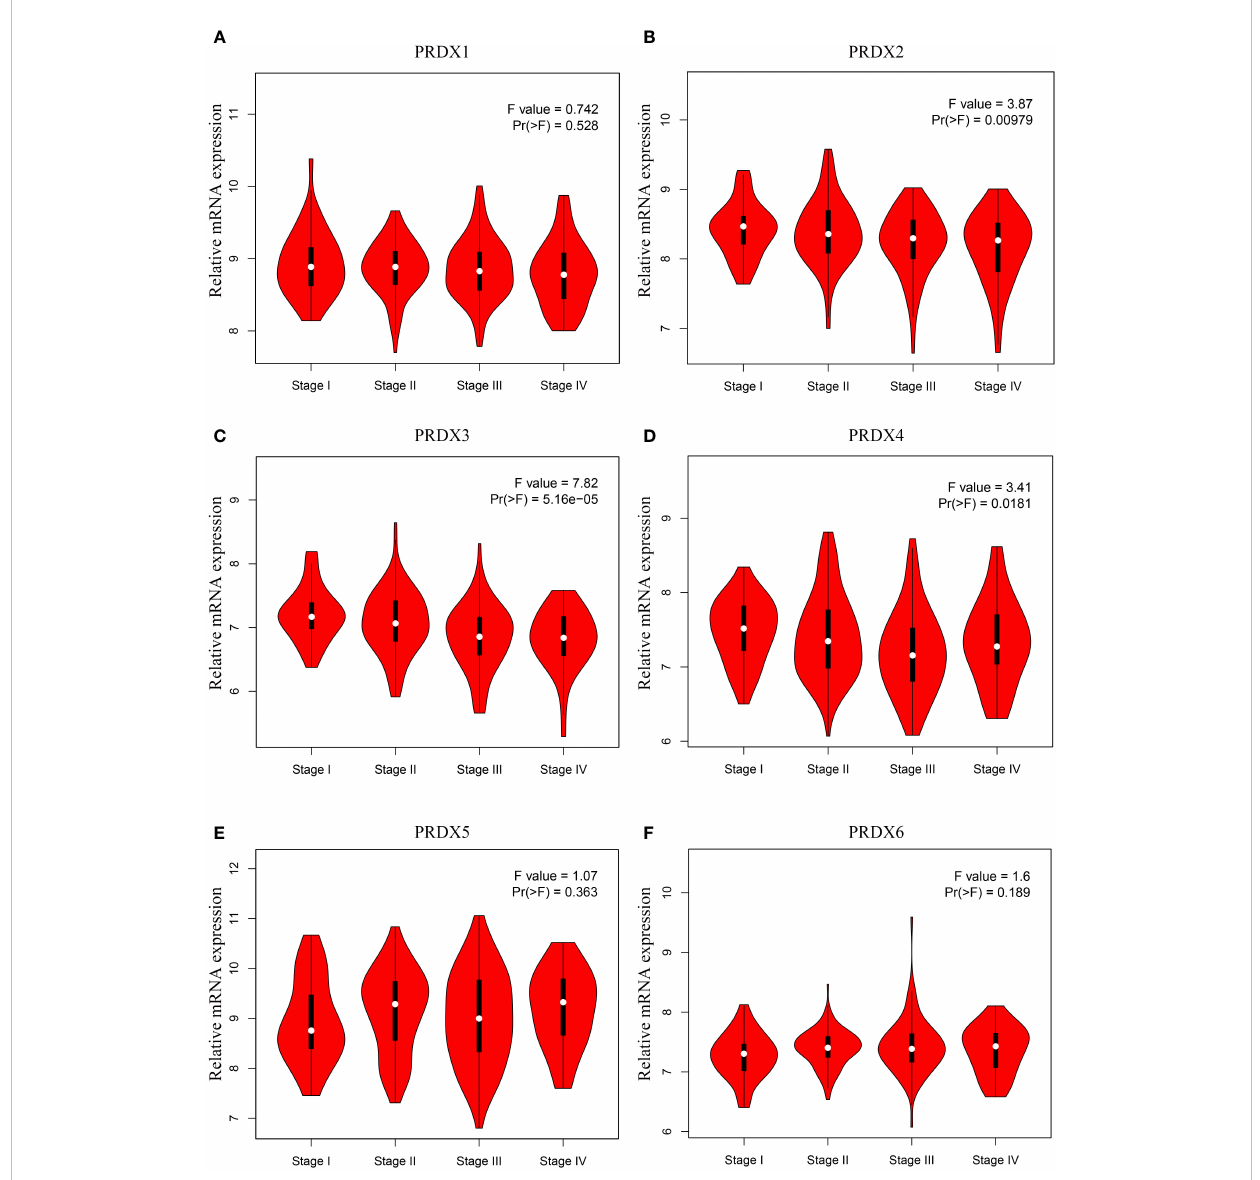
FIGURE 4 (A-F) Association between mRNA expression of PRDXs and tumor stage in COAD patients (GEPIA). The expression of PRDX2, PRDX3 and PRDX4 was signi fi cantly correlated with the pathological stage of COAD patients ( P < 0.05). COAD, colon